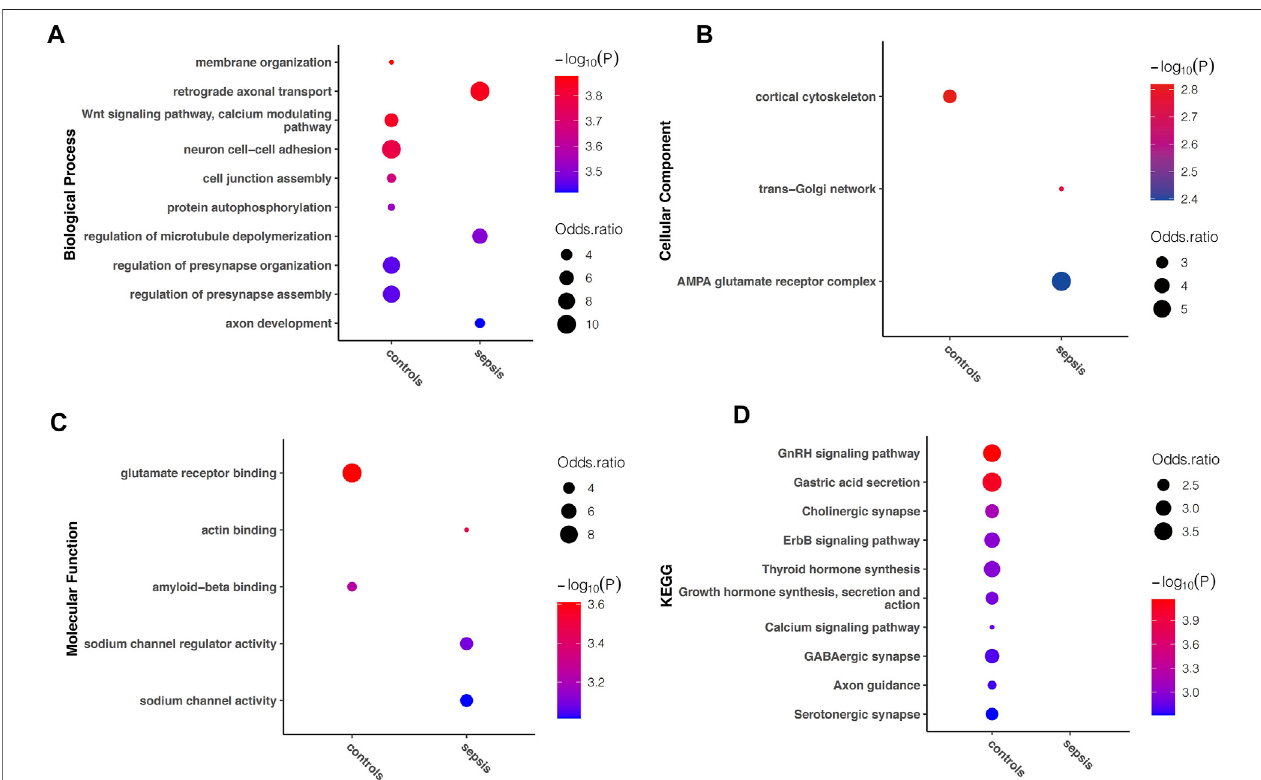
FIGURE 4 | Difference in Gene Ontology and KEGG pathway enriched in sepsis and controls, respectively. The top (showing up to 10) terms with FDR < 0.05 are shown for (A) biological processes (B) molecular functions, and (C) cellular components, as well as (D) KEGG pathways uniquely enriched in either sepsis or controls.